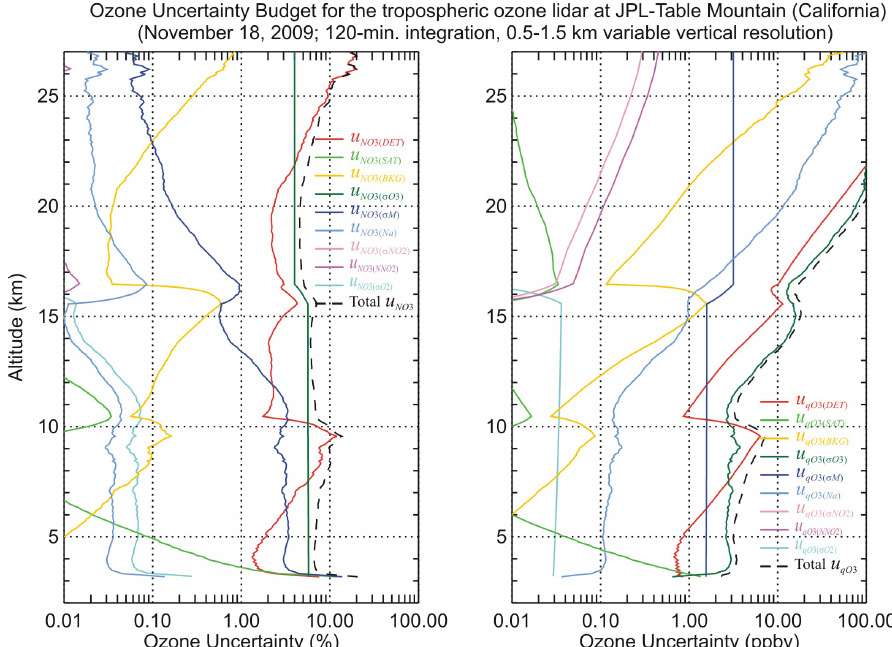
Figure 17. Same as Fig. 16, but for the tropospheric ozone DIAL system located at the JPL Table Mountain Facility (California) (nighttime